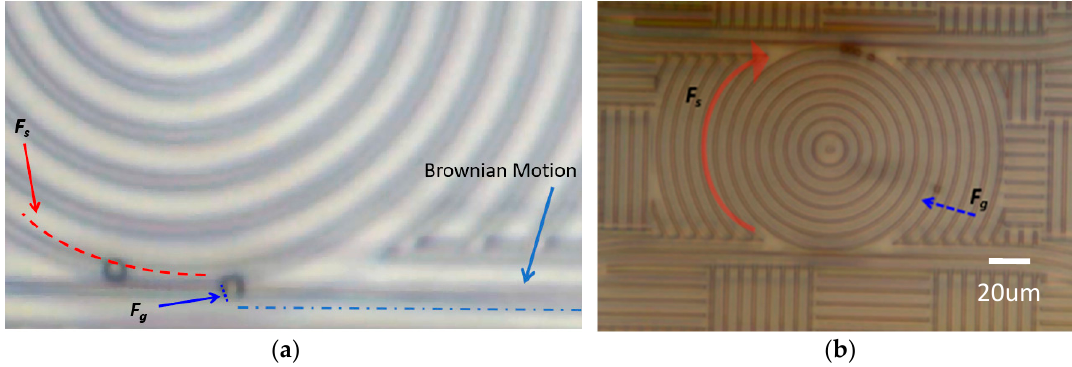
Figure 5. ( a ) The optical image of the ring resonator (highlighted by the red dotted line with the ring and the blue dotted line with the bus) prior to the EDFA being switched on. This figure shows two beads delivered along the bus waveguide to the ring. The average speed of a bead on the bus and the ring is 3.13 µ m / s and 40.38 µ m / s, and the electrical field of the ring is stronger than the bus waveguide. ( b ) The demonstration of the two trapping forces produced by the intensity in the waveguide. The four beads are being pushed around the ring resonator by the scattering force F s indicated by the red arrow, and the single bead outside the ring is being pulled toward the waveguide by the gradient force F g , indicated by the blue arrow.